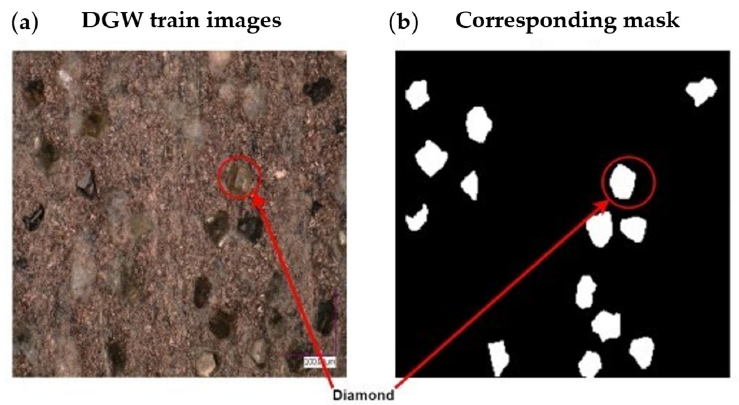
Figure 5. ( a ) DGW training images. ( b ) Corresponding binary mask